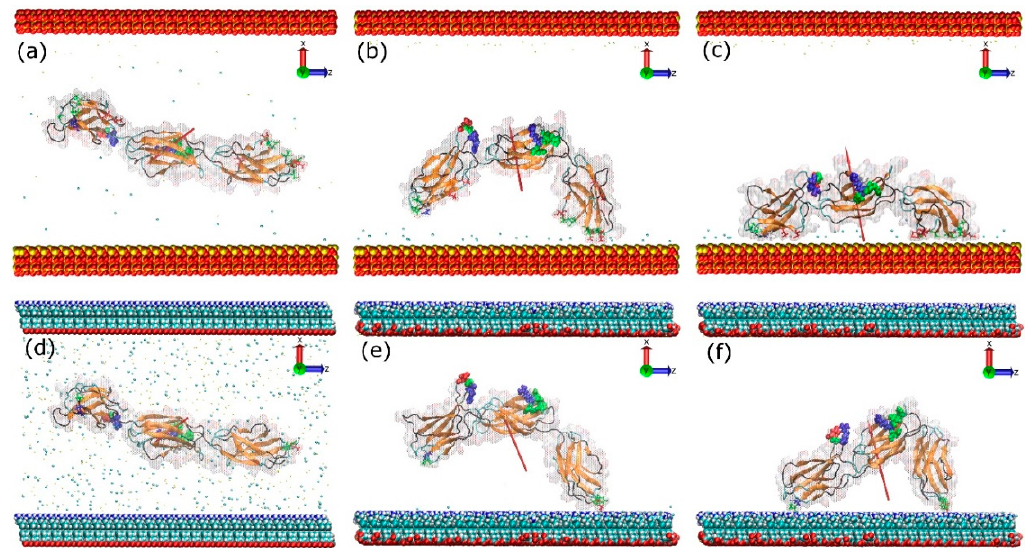
Figure 3. Adsorption process of FNIII 8–10 on the model silica (top) and amine surface (bottom): t = 0 ns ( a , d ), anchoring event ( b , e ), end of simulation ( c , f ). The red arrows indicate the dipole moment of the protein, while the colour-coding is the same as that used in Figure 1. The water molecules are not shown.